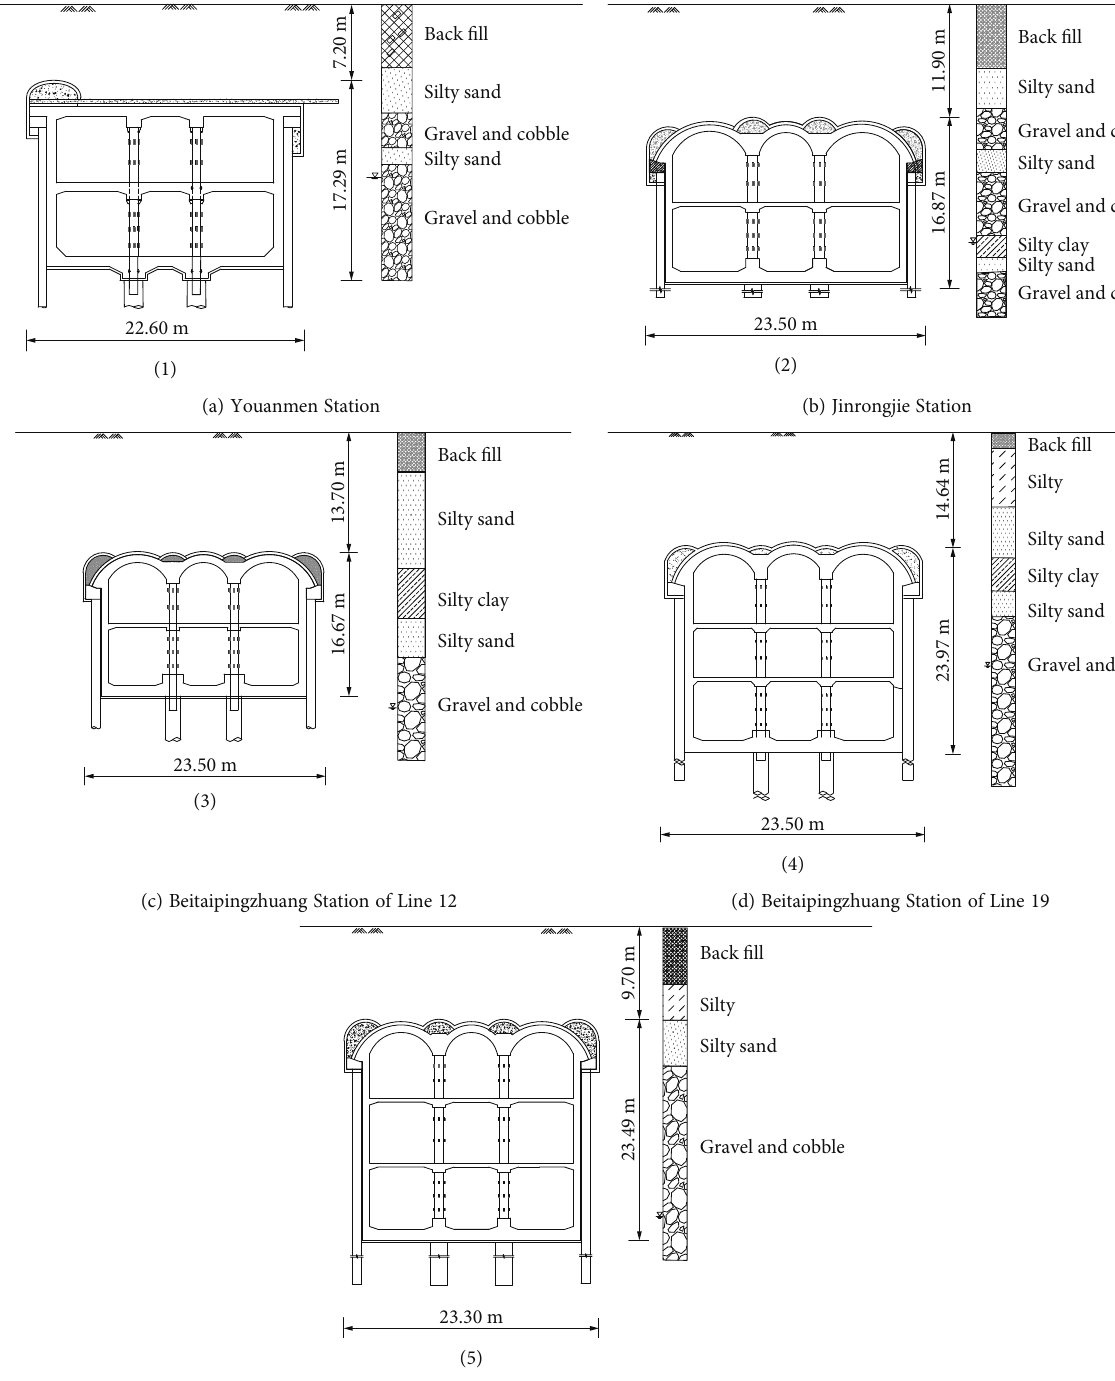
Figure 4: Cross sections of the pile foundation stations of the Beijing